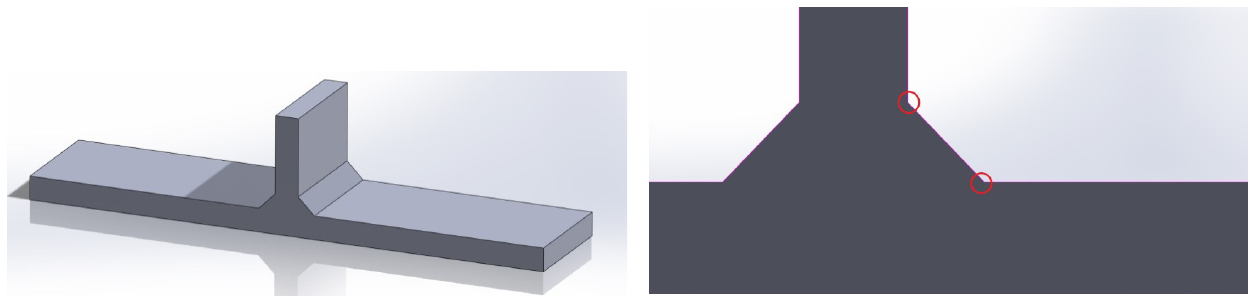
Figure 9: Three-dimensional geometry.